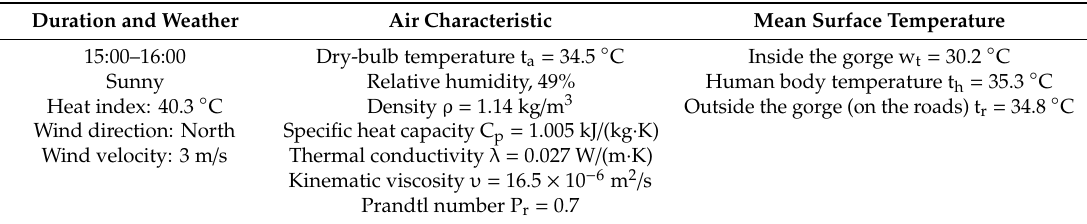
Table 2. Parameters for calculation of the heat transfer rate over the pedestrian’s